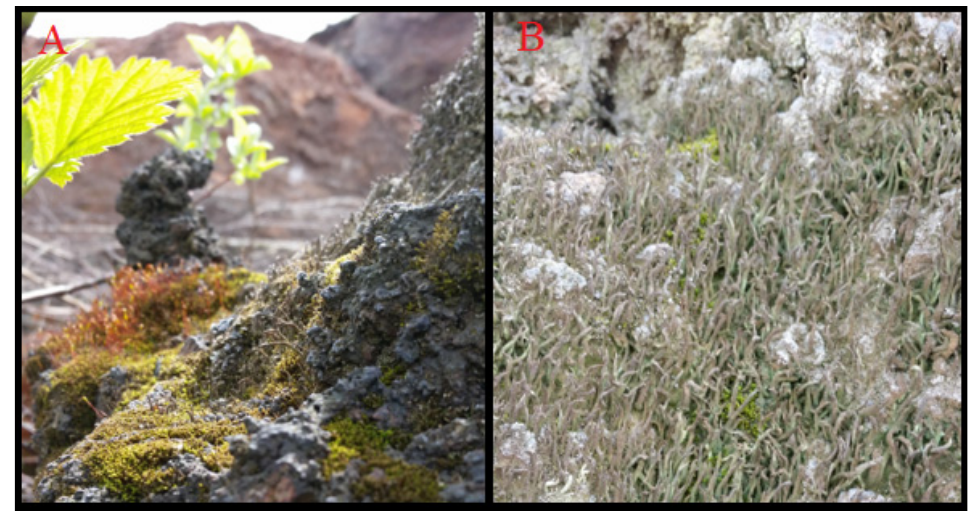
Figure 8. An example of firefly moss ( Polytrichum commune Hedw. , A ) and lichen ( Cladonia sp. , B )